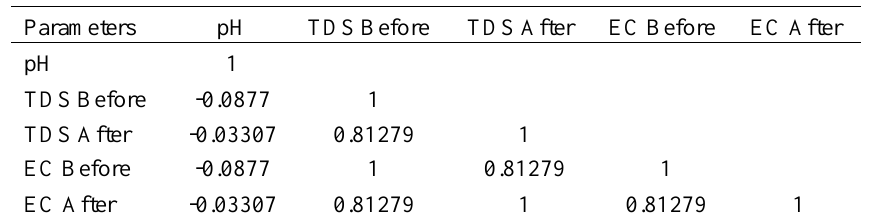
Correlation of parameters